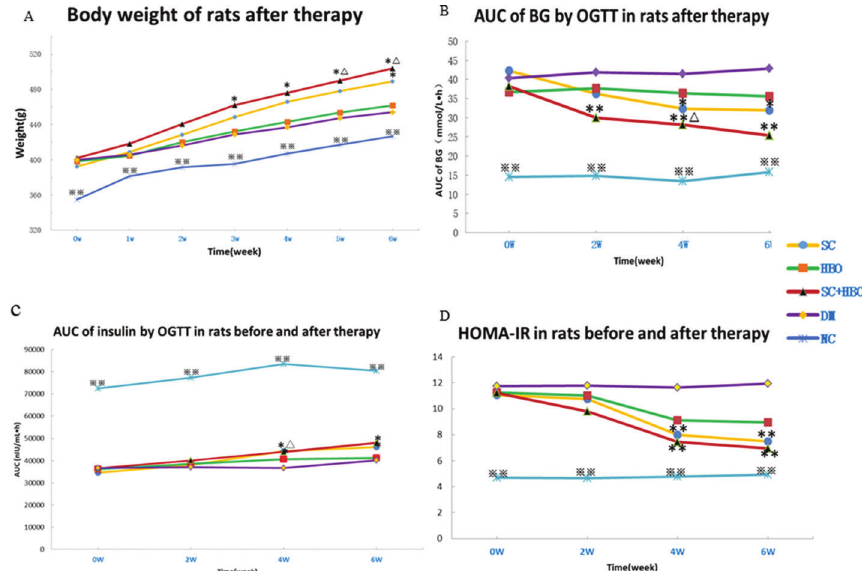
Figure 1 - Body weight and glucose metabolism indices of rats. A . Body weight: After 3 weeks of therapy, the body weights of the rats from the SC + HBO group were higher than those of the rats from the DM group. After 5 weeks, the body weights of the rats from the SC + HBO group were higher than those of the rats from the HBO group. After 6 weeks, the SC group rats had higher body weight than the DM group rats. B. AUC of BG by OGTT: After 2 weeks of therapy, the AUC for the rats from the SC + HBO group was lower than that for the rats from the DM group. The AUC value decreased for SC group rats as compared with that for DM group rats after 4 weeks. The AUC of SC + HBO group rats was lower than that of HBO group rats. C. AUC of INS by OGTT: After 4 weeks, the AUC started to increase for the rats from SC + HBO and SC groups as compared with that for the rats from DM group. D. HOMA-IR: After 4 weeks, the HOMA-IR for SC + HBO and SC group rats was lower than that for DM group rats. * p o 0.05, ** p o 0.01 vs DM group, W p o 0.05 vs HBO group. :: p o 0.01 vs each of the other four groups.